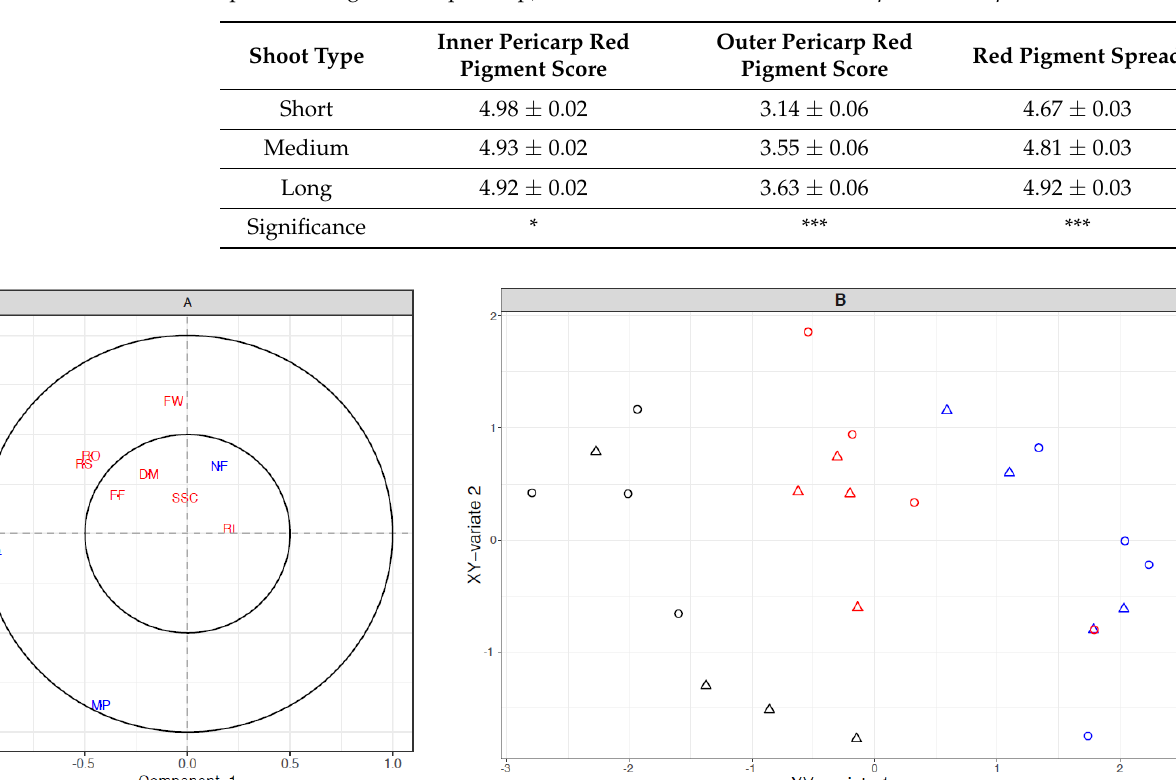
Table 2. The effect of shoot type (short, medium or long) of red-fleshed Actinidia chinensis var. chinensis ‘Zes008’ fruit red pigment scores in the inner pericarp and outer pericarp of fruit, and the spread of red pigment through the fruit tissues at harvest (168 DAA). Flesh colour was measured using a scale of 0 to 5 (0 = absent; 5 = very intense red) and the spread of red pigment throughout the fruit pericarp tissues was also scored on a 0 to 5 scale (0 = no red pigmentation; 5 = red pigmentation spread throughout the pericarp). Data are means ± SEM, n = 50. * p < 0.05; *** p < 0.001.